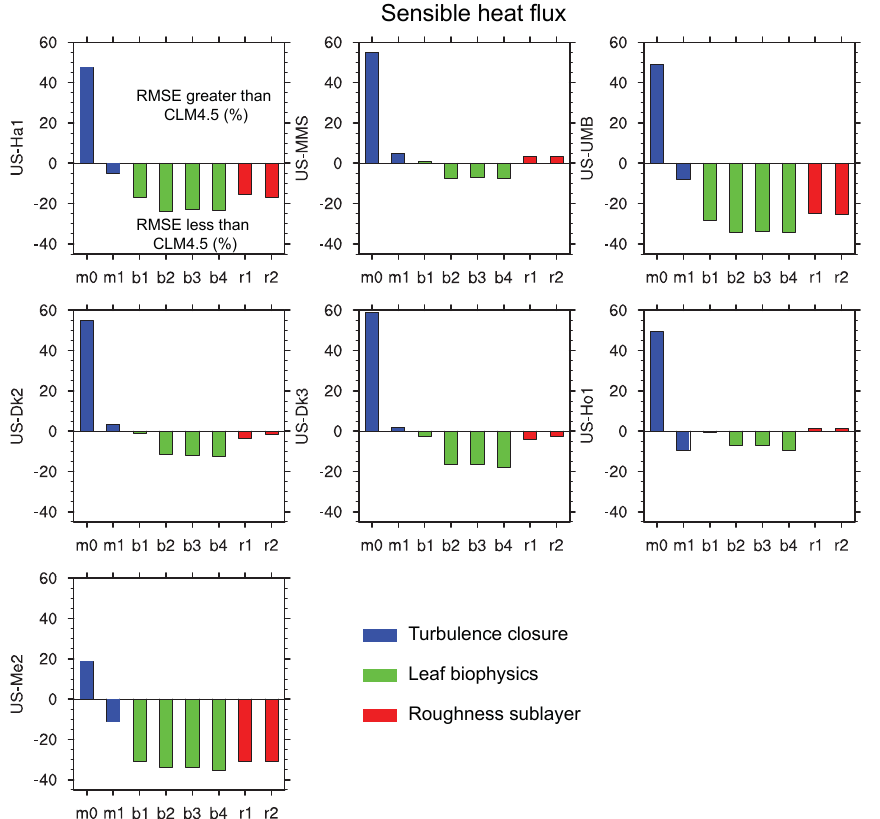
Figure 8. As in Fig. 7, but for sensible heat